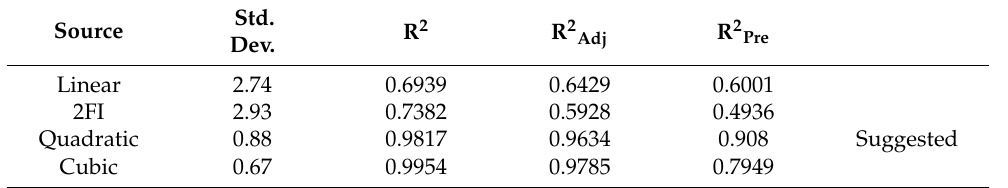
Table 5. Comparison of Model